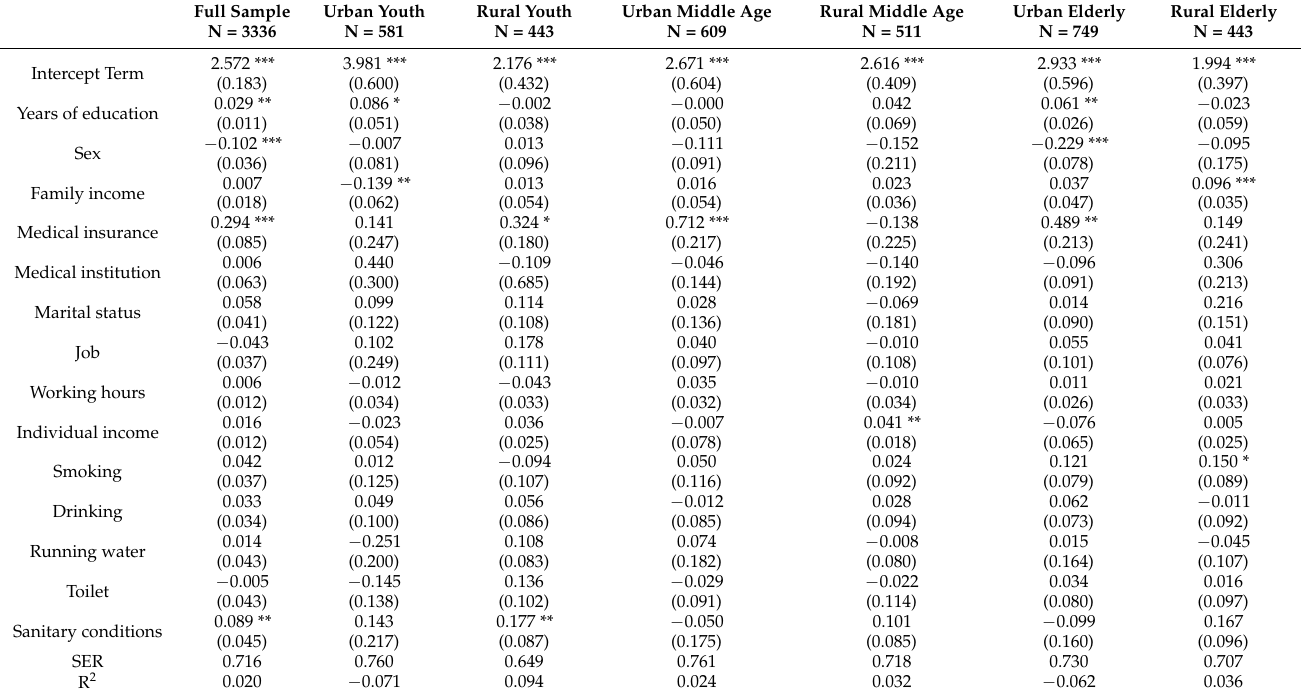
Table A10. Results of two-stage least squares (by age and residence, for psychological